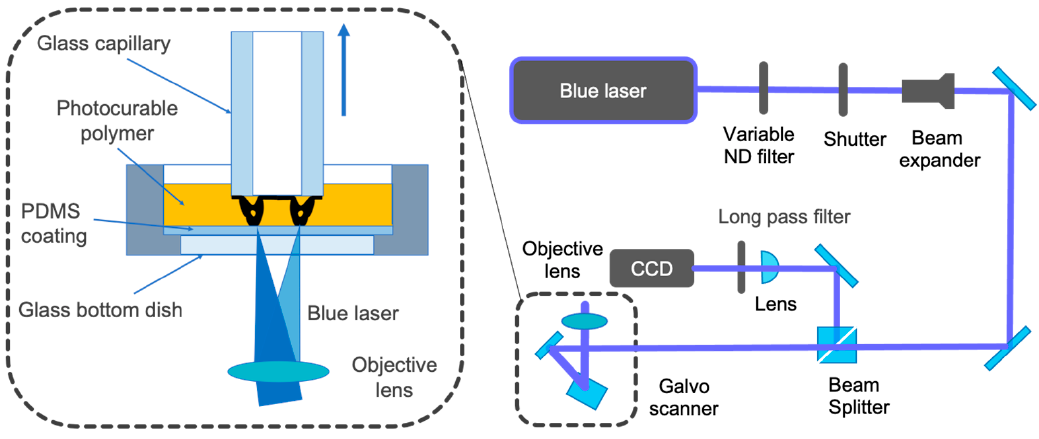
Figure 2. High-resolution microstereolithography system using a blue laser.